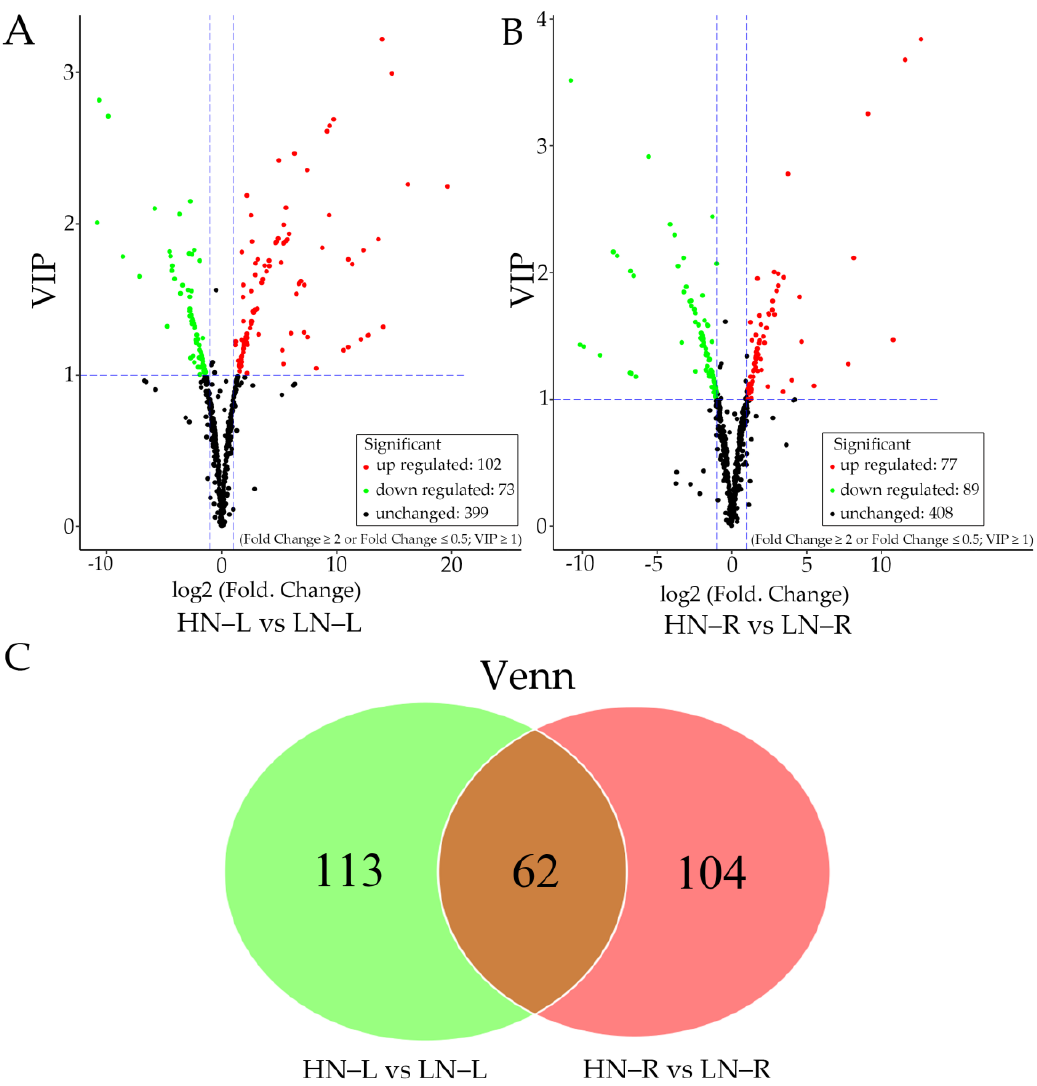
Figure 3. Volcano plot and Venn diagram analysis of differentially accumulated metabolites of rapeseed. ( A ) Volcano plot of differentially accumulated metabolites of rapeseed between HN-L and LN–L; ( B ) Volcano plot of differentially accumulated metabolites of rapeseed between HN-R and LN–R. The red points, green points, and black points indicate metabolites whose accumulation significantly increased, decreased, and was not significantly different, respectively. ( C ) Venn diagrams of the numbers of significantly differentially accumulated metabolites in leaves and roots between HN and LN conditions. The green and pink represent significantly differentially accumulated metabolites only in HN/LN–L and HN/LN–R, respectively. The brown represents significantly differentially accumulated metabolites detected both in HN/LN–L and